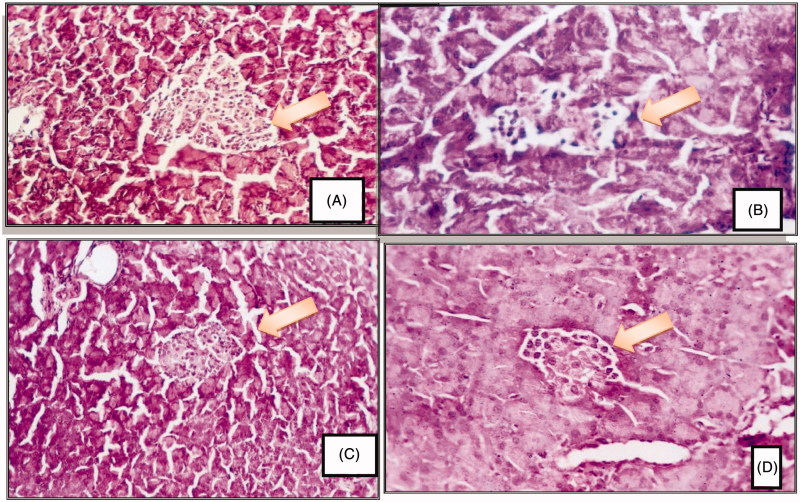
Photomicrographs are representative of cross sections from six rats stained with hematoxylin and eosin. (A) showing pancreas of normal rat with normal pancreatic tissue including islets of Langerhans, pancreatic acini and ducts, (B) showing pancreas of diabetic rat with islet destruction, reduction in size and lymphocytic infiltration, (C) representing pancreas of Momordica charantia pretreated diabetic rat showing mild islets destruction, (D) showing pancreas of diabetic rat treated with Momordica charantia with moderate islet destruction (H&E 250×).